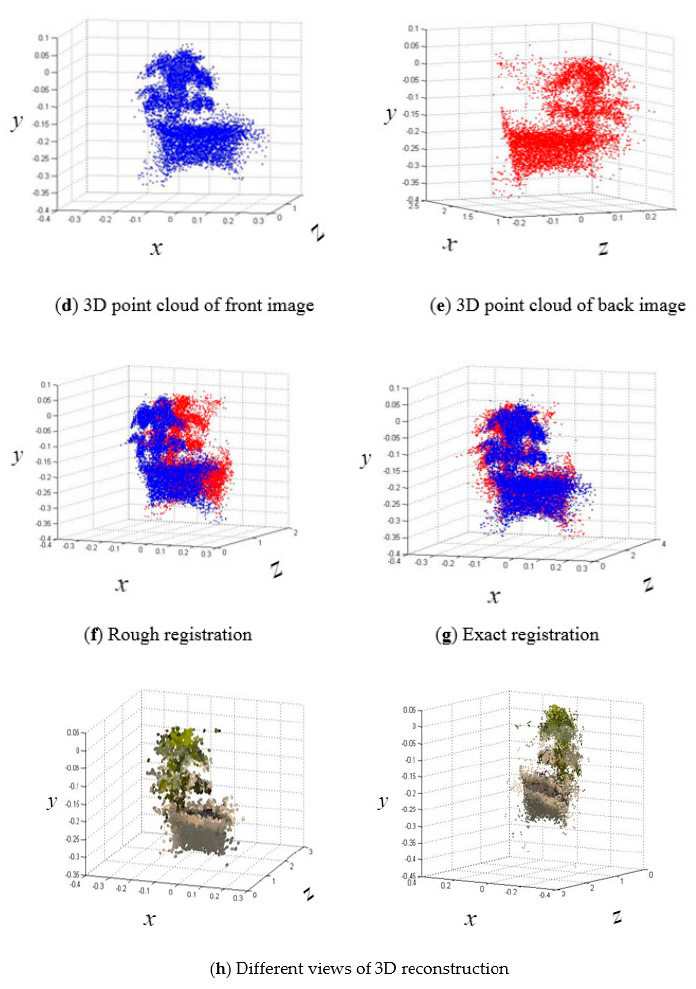
Figure 8. Reconstruction results of soybean plants from the side view.